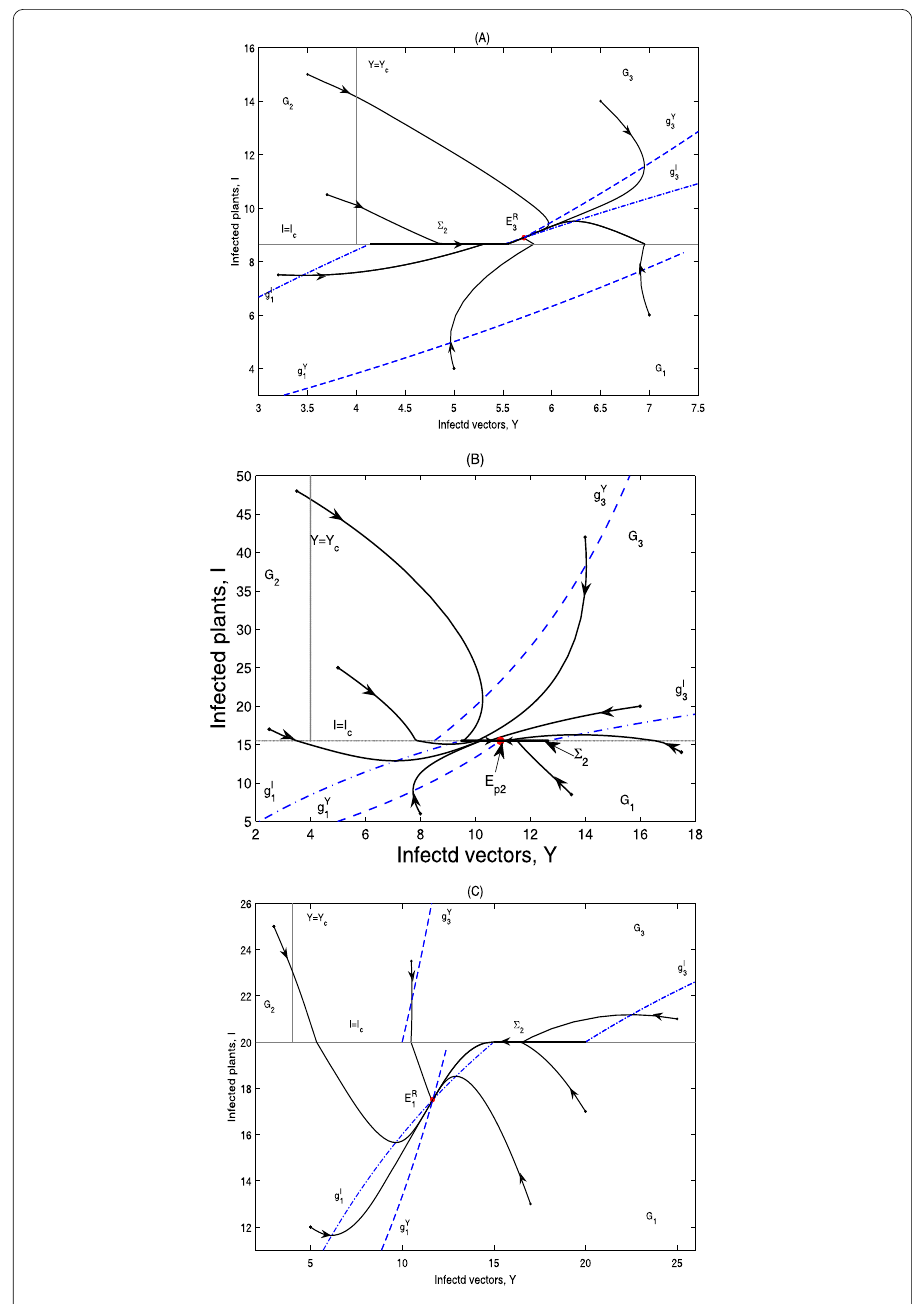
Figure 5 Global dynamics in Case A.13. ( A ) E R 3 is globally asymptotically stable. Y c = 4, I c = 8.65. ( B ) E p 2 is globally asymptotically stable. Y c = 4, I c = 15.5. ( C ) E R 1 is globally asymptotically stable. Y c = 4, I c =